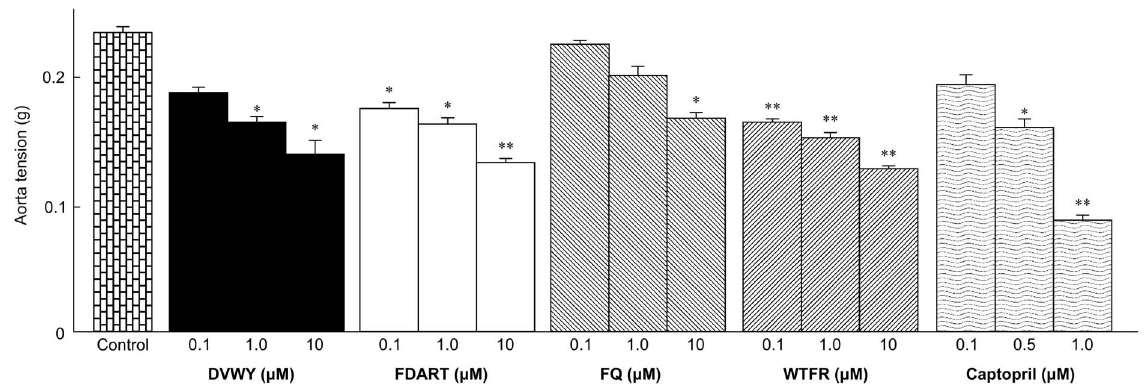
Figure 4. Vascular tension changes after incubation with angiotensin I and DVWY, FDART, FQ, WTFR, and captopril. Tension changes were measured using SHR thoracic aorta rings incubated in 0.2 m M angiotensin I with DVWY, FDART, FQ, WTFR, and captopril (positive control). Data represent the mean 6 S.E. (n=3). * p , 0.05, ** p , 0.01 versus the negative control group (Krebs solution treatment) by Student’s t -test.